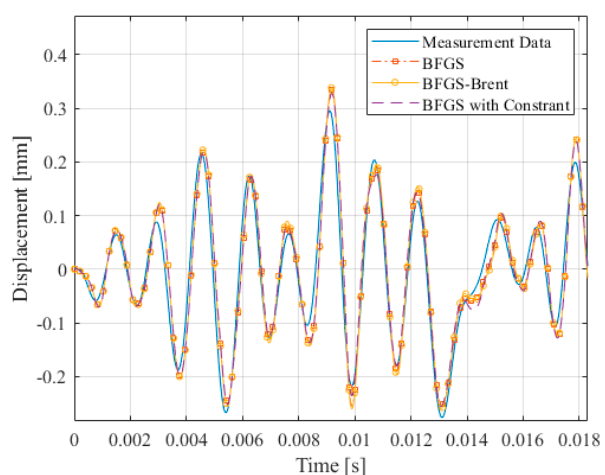
Figure 13. Comparison of displacement values obtained using the capacitance sensor and different methods.